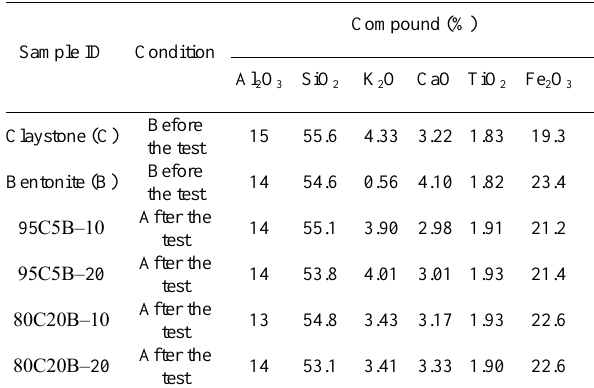
Table 3. Oxides of claystone, bentonite, dan claystone‒bentonite mixtures